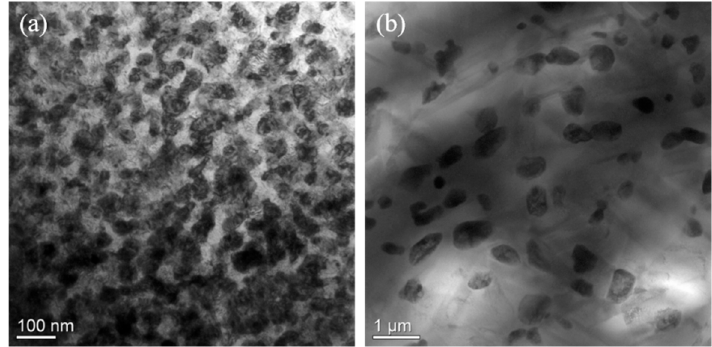
Figure 6. TEM bright images of the Zr-40Nb-25Ti alloy samples ( a ) annealed at 850 K and ( b ) annealed at 900 K.